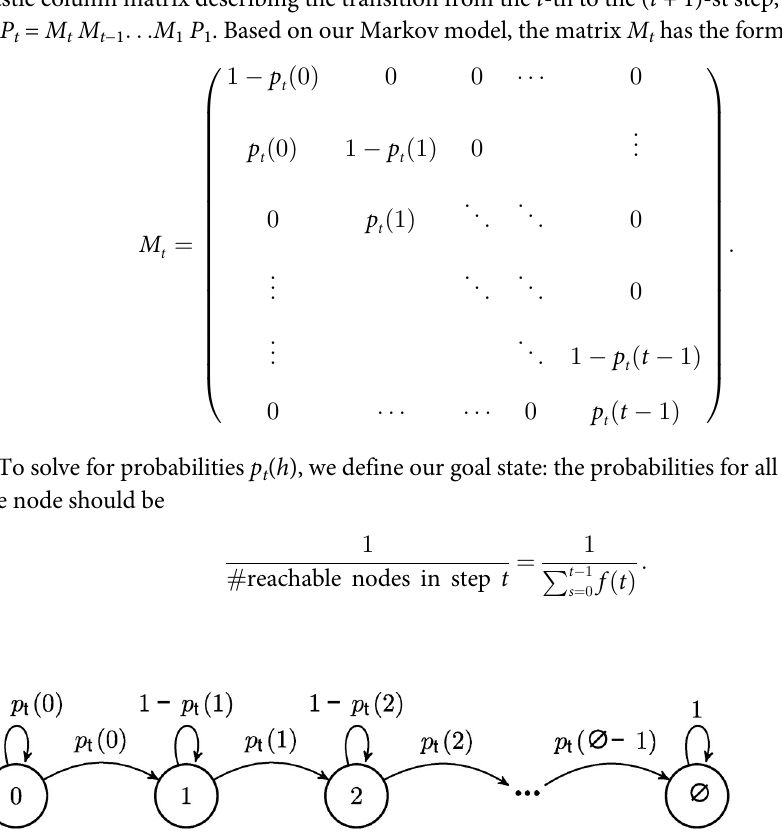
Fig 2. Time inhomogeneous Markov chain of passing the virtual source